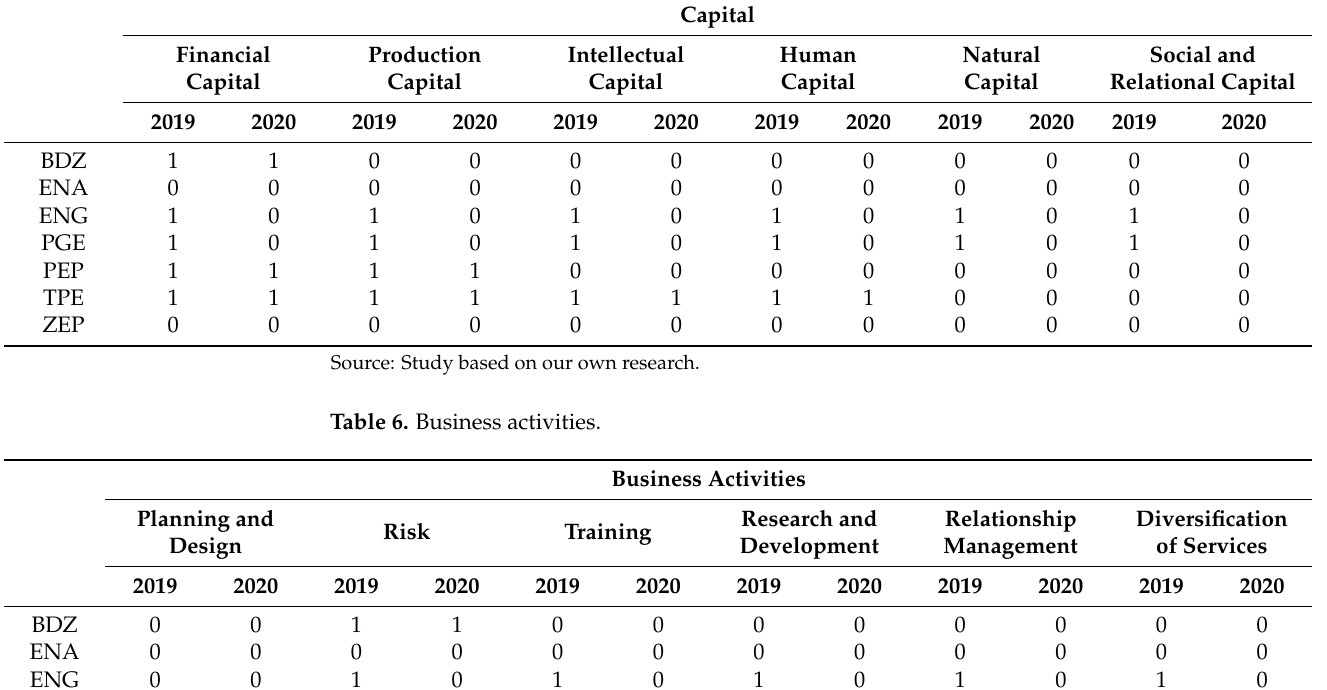
Table 5. Input elements—the capital of the business models of enterprises in the energy sector for the